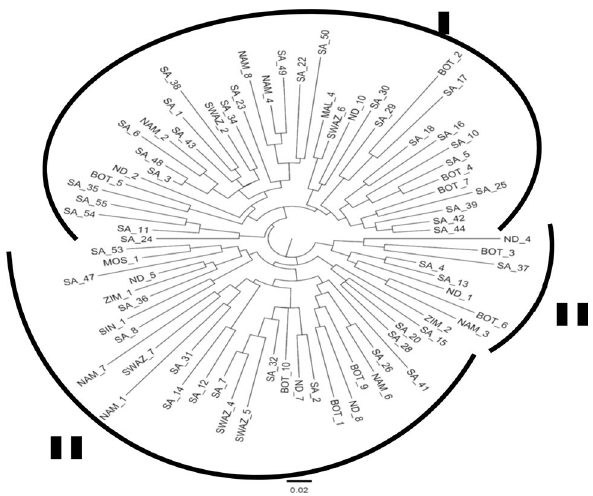
Figure 1. Rooted neighbor-joining (NJ) tree constructed with DARwin 6.0.19 software, illustrating clusters for the 78 Bambara groundnut landraces.